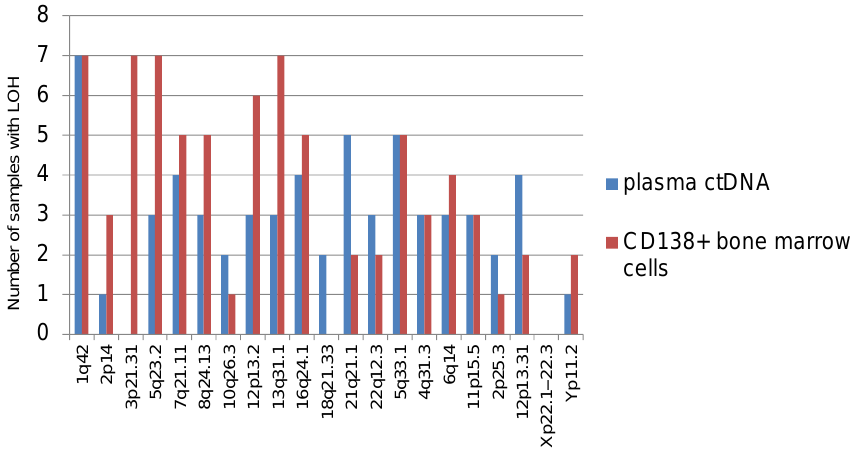
Figure 2. Chromosomal localization of LOH in plasma ctDNA and bone marrow samples.